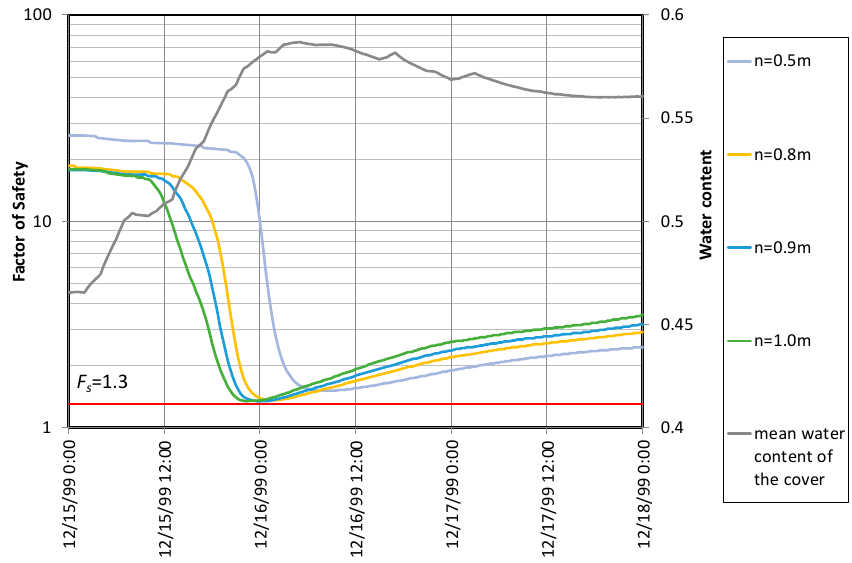
Figure 8. Predicted factor of safety F S at various depths (calculated at s = 150 m as representative of most of the slope length), and mean water content of the soil cover, between 15–17 December 1999, when a landslide occurred at Cervinara.